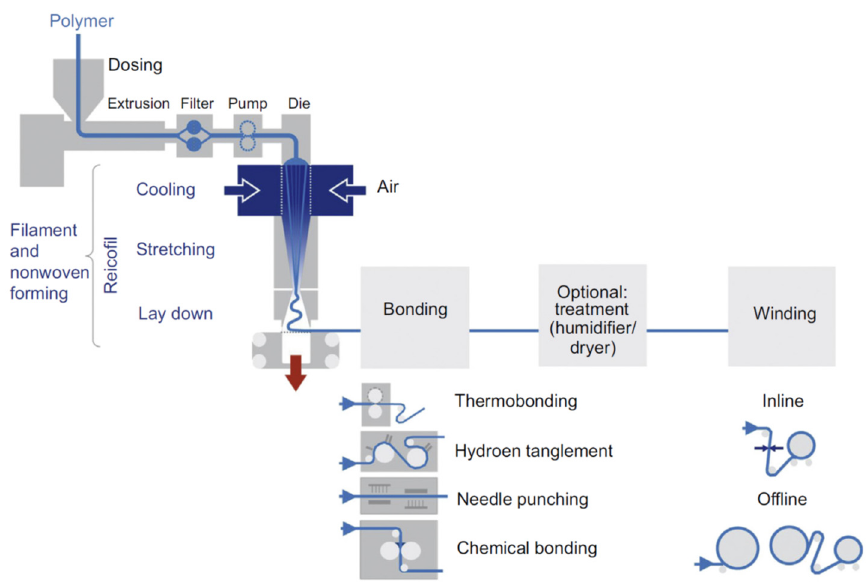
Figure 1. The setup of the spunbond process. (Reprinted with permission from [8]. Copyright 2016 Elsevier).